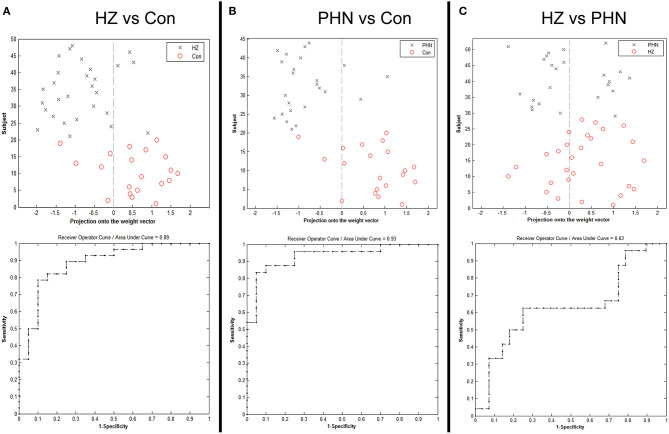
Classification plot and receiver operating characteristic curve for the comparison between the groups using mean amplitude of low-frequency fluctuation value from the region of interest. (A) Classification between herpes zoster (HZ) and healthy controls (HC), (B) classification between postherpetic neuralgia (PHN) and HC, and (C) classification between HZ and PHN.